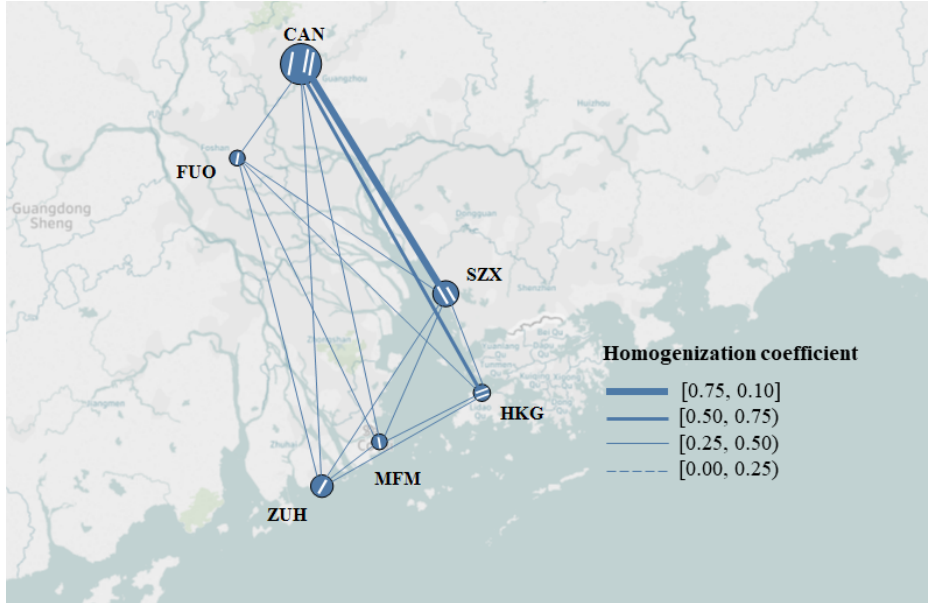
Figure 7. Illustration of comprehensive homogenization in the Greater Bay MAR. Table 2. Main results (homogenization coefficient).